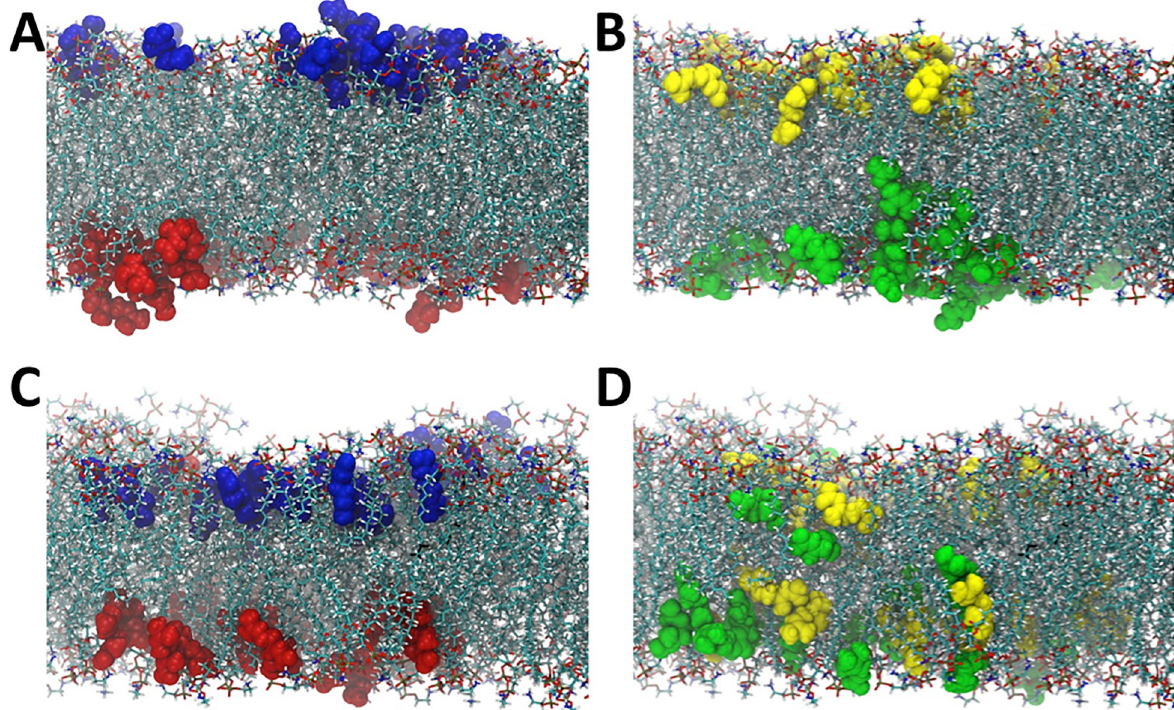
Fig 7. CAGE migration over time within leaflets of the membrane bilayer. Snapshots from the symmetric bilayer simulation with the CAGE components colored according to the leaflet they begin in. Panel A depicts an early production configuration, which shows geranate anions are highlighted in the top leaflet in blue and in the bottom leaflet in red and panel C shows the final configuration after 130 ns of simulation with anions all remaining within the leaflet that they begin. Similarly, panels B and D show geranic acid molecules at the beginning (panel B) and the end (panel D) after 130 ns of the production phase. The yellow and green molecules indicate molecules that begin in the upper (yellow) or lower (green) leaflets. The geranic acid is found to more freely traverse across the bilayer and randomize during our simulation as indicated by the yellow and green molecules randomizing at the end of the production